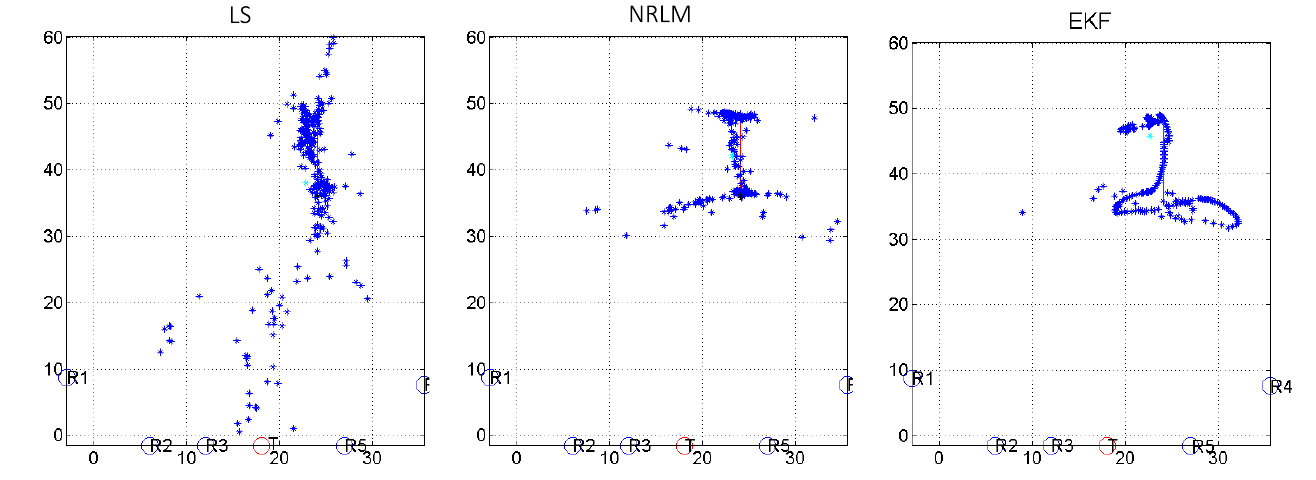
Figure 14. Case 3-3: Target moves from (20, 36) to (20, 48), the velocity in the y -direction is about 1 cm/s. (Blue dots: the estimated coordinates of moving target; red line: the reference target trajectory.)